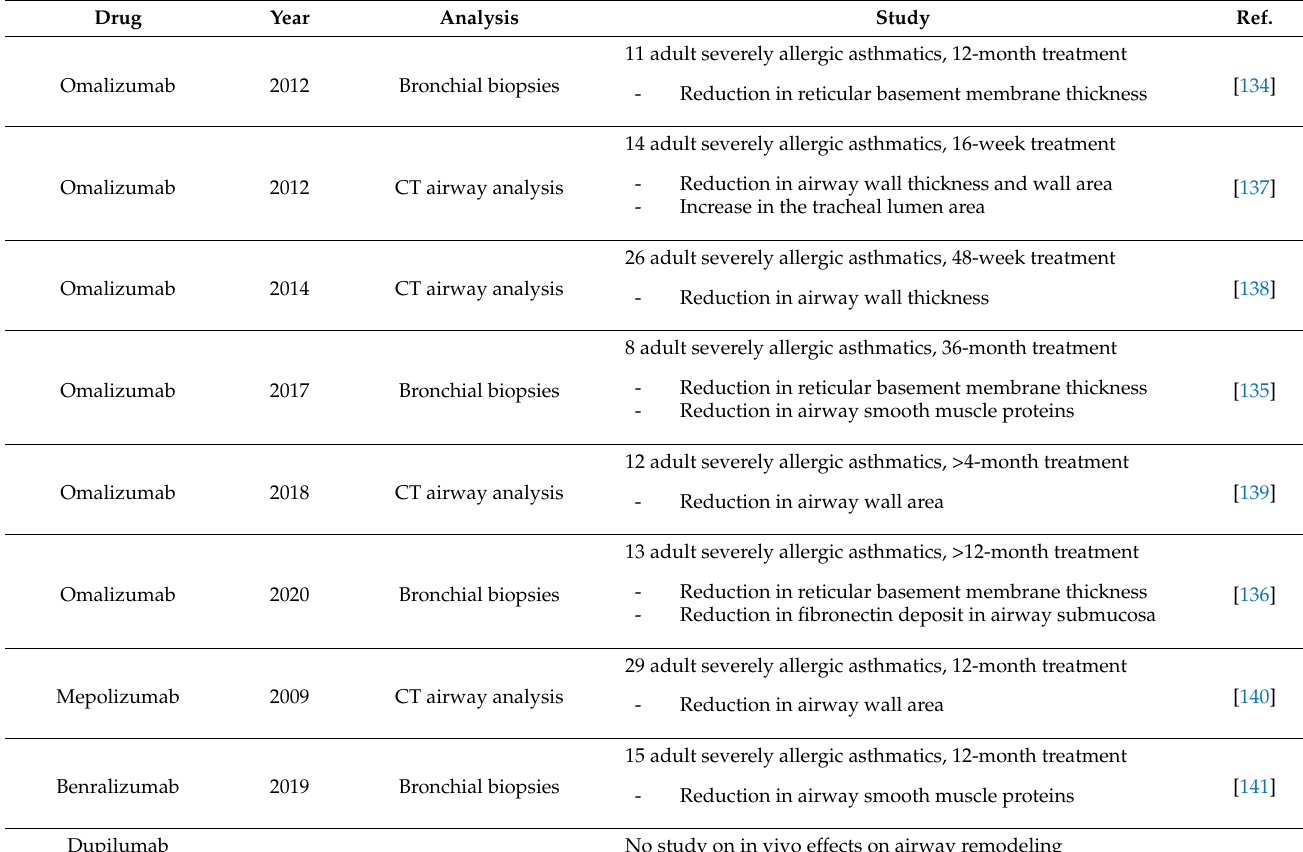
Table 1. Summary of biological drugs in vivo effects on airway